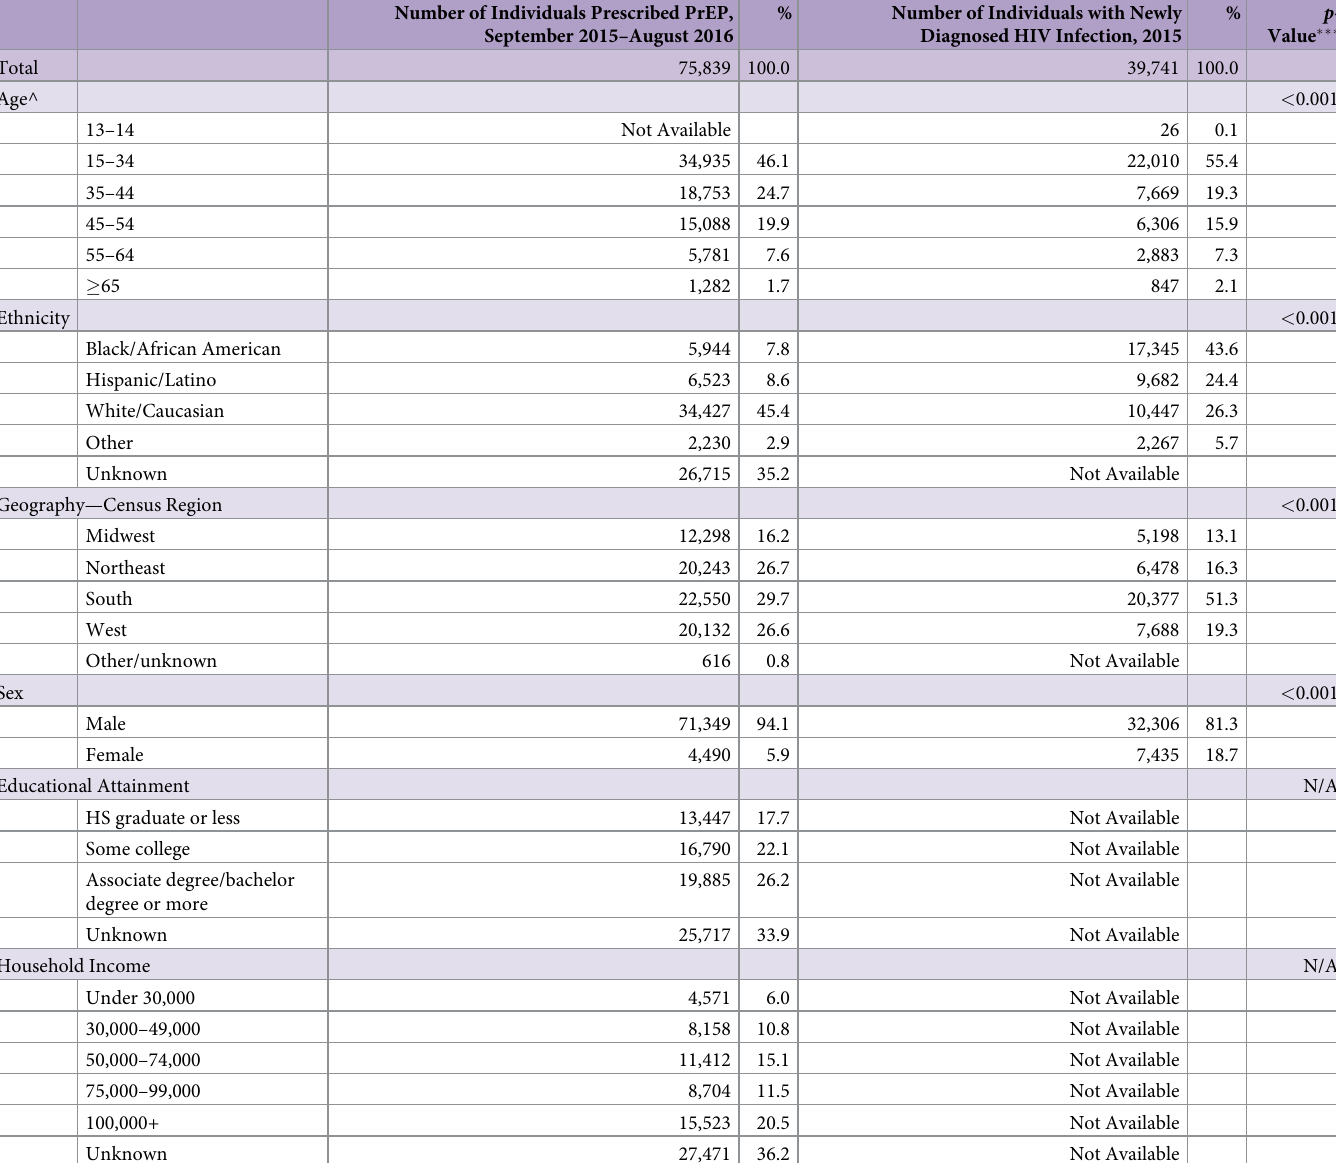
Table 1. Demographic characteristics of individuals prescribed PrEP in IDV database and adults and adolescents diagnosed with HIV infection reported to the CDC in 2015. Number of Individuals Prescribed PrEP, % Number of Individuals with Newly September 2015–August 2016 Diagnosed HIV Infection,